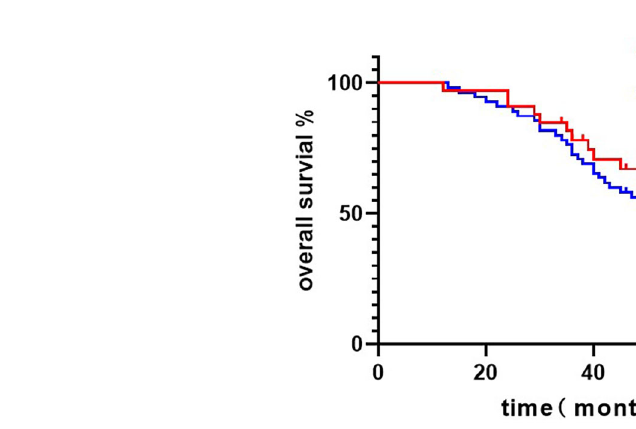
FIGURE 1 Kaplan – Meier curves of overall survival comparison in patients treated with group 1 versus group 2. 5-years-OS = (group 1: 53.60%, group 2: 52.80%; P = 0.657; HR = 0.855; 95CI = 0.429 to 1.705). Log-rank test: